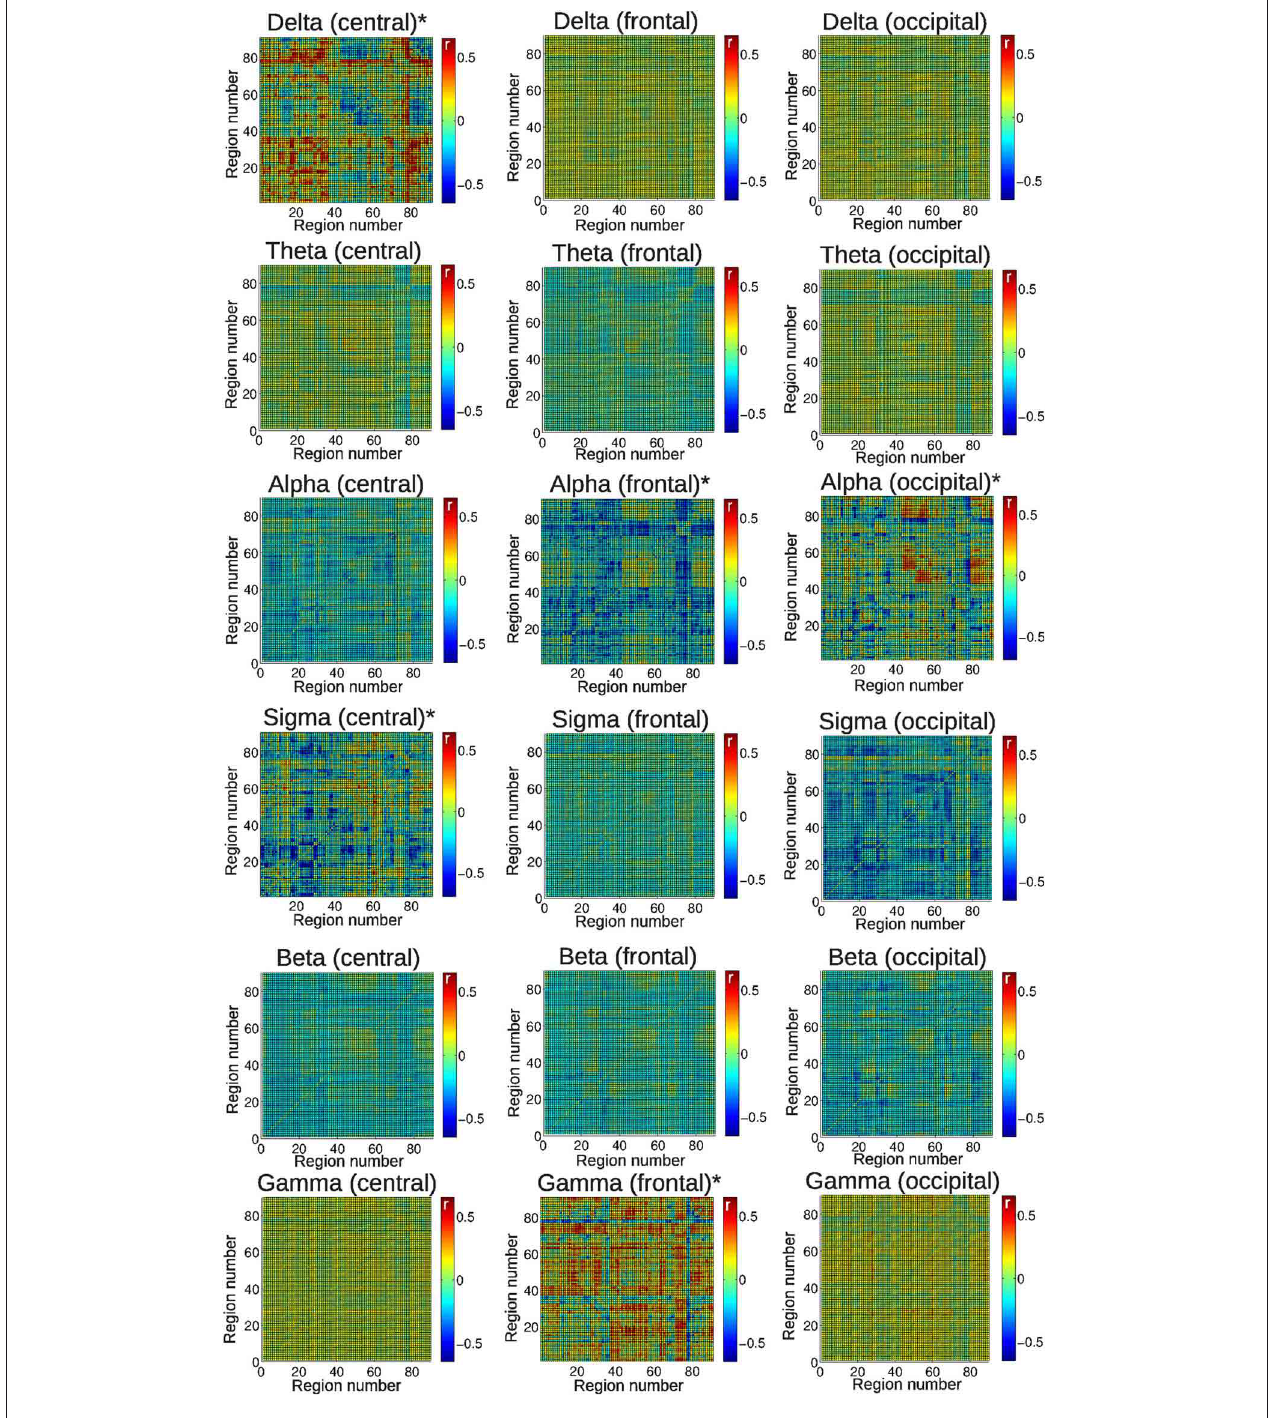
FIGURE A2 | Mean correlation between BOLD functional connectivity and EEG power fluctuations for all frequency bands and scalp regions under study. Results are for the wake and drowsy group